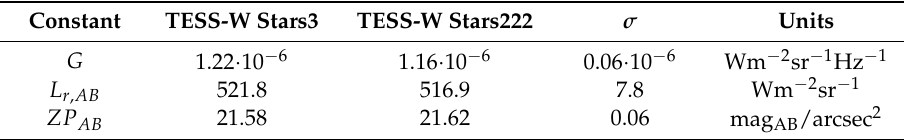
Table 1. Calibration constants of the TESS-W night sky brightness meters.